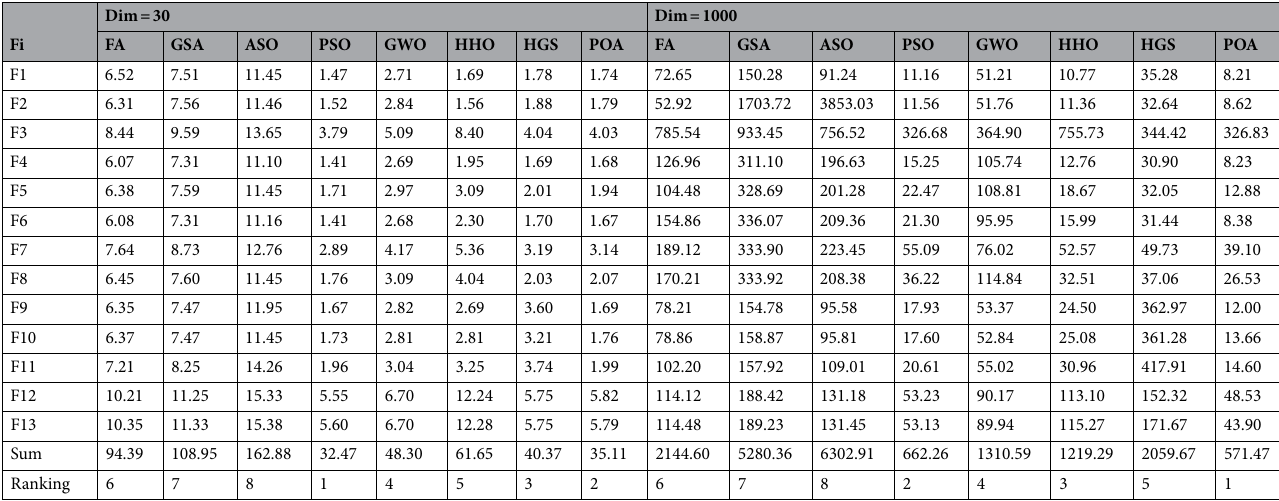
Table 6. Wall-clock time costs (second) on benchmarks of POA and other participants.